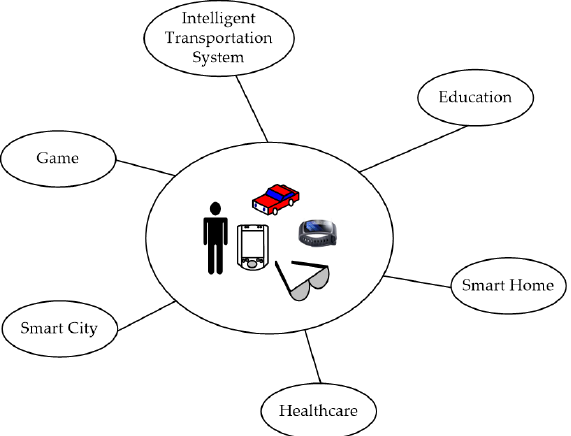
Figure 1. Examples of IoT application using personal